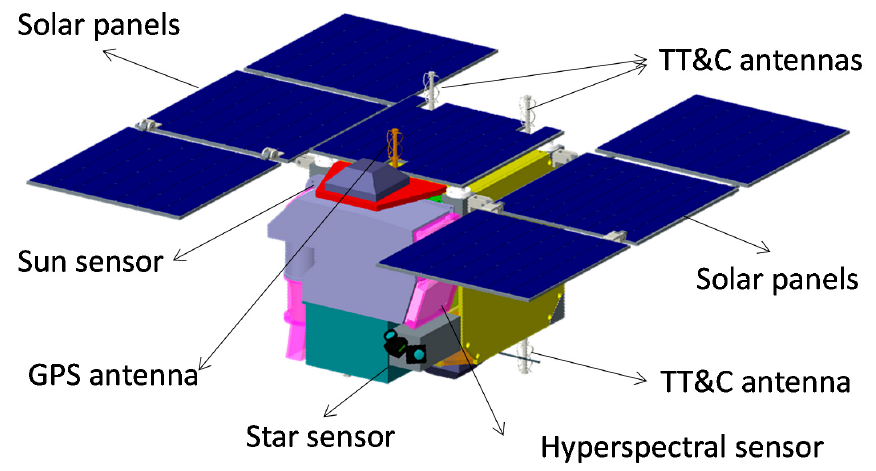
Figure 1. Diagram of the SPARK satellite. Table 1. Main characteristics of SPARK satellite and imaging sensor.